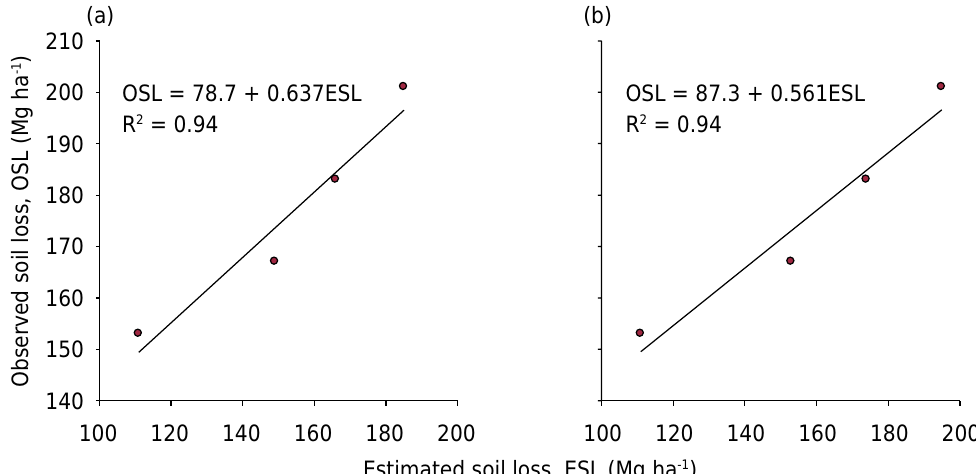
Figure 5. Relation between the values of observed soil loss (OSL) and the values of estimated soil loss (ESL); estimates made (a) by the USLE and (b) by the RUSLE in each treatment (average of